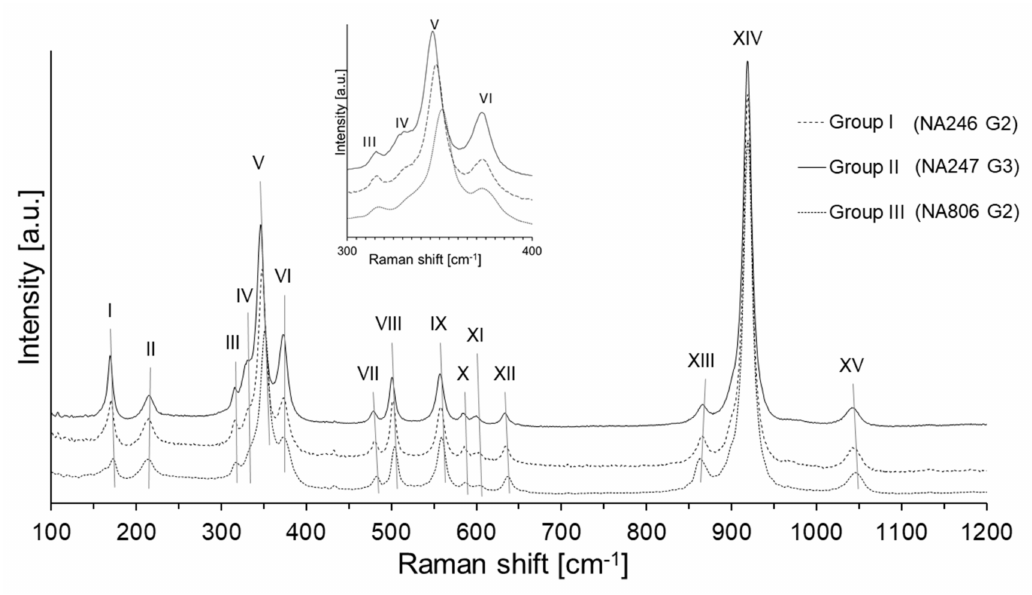
Figure 6. Raman spectra of almandine garnets, representative for each